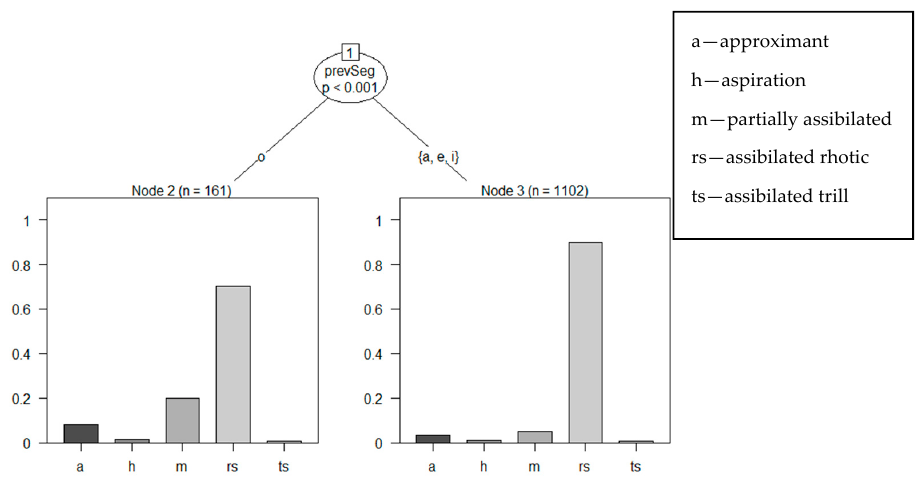
Figure 4. Conditional inference tree in R showing the distribution of phrase-final rhotic given preceding vocalic context /a/, /e/, /i/, /o/.